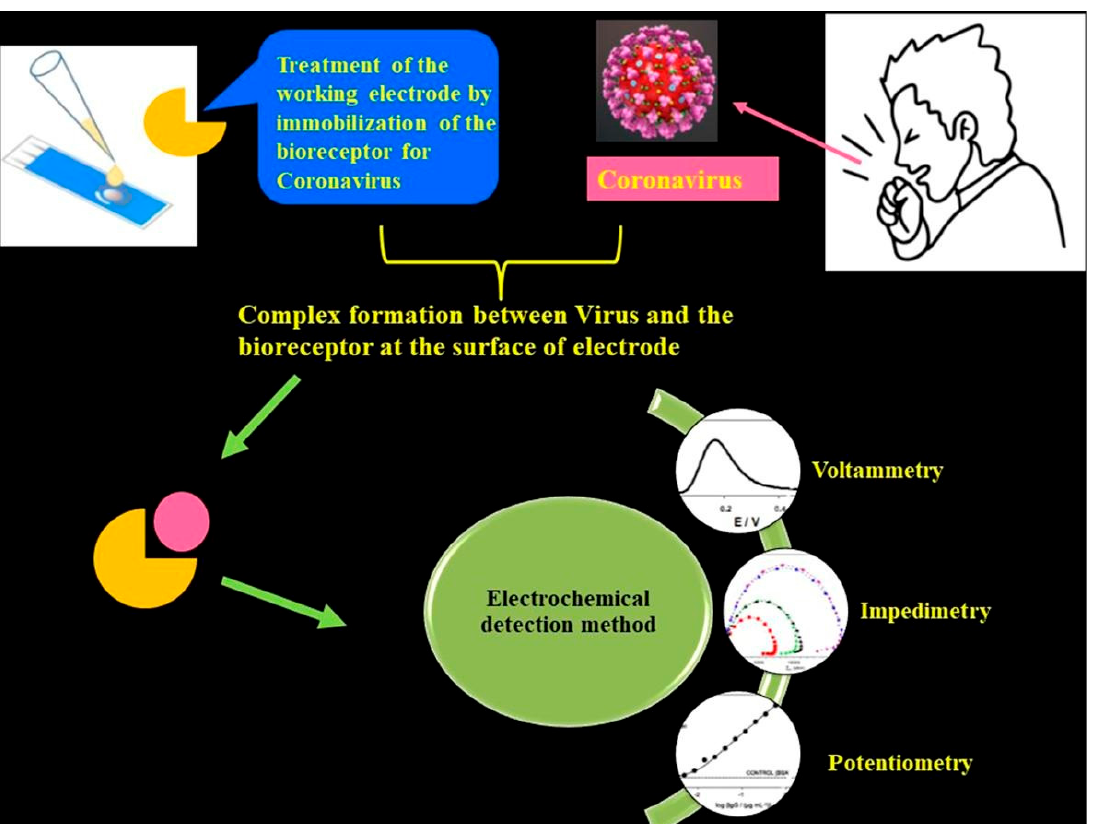
Figure 2. Schematic of an electrochemical COVID-19 detection technique using voltametric, impedimetric and potentiometric sensors. Reproduced with permission from Ref. [1]. Copyright 2022 Elsevier.